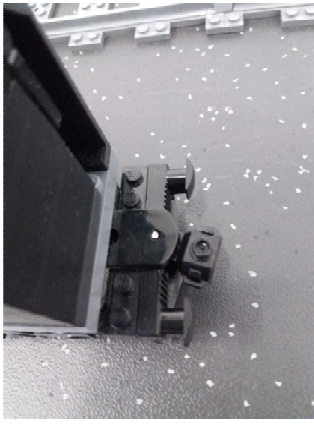
Figure 5. Train coupler